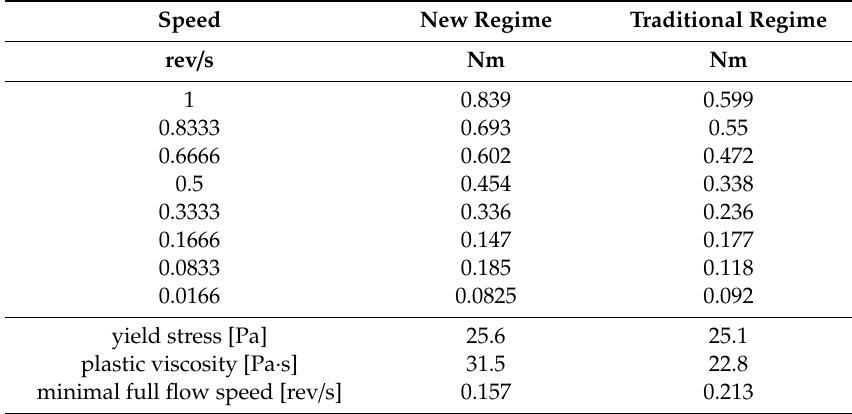
Table 4. Raw data from the measuring and calculated values based on the Reiner-Riwlin equation for the